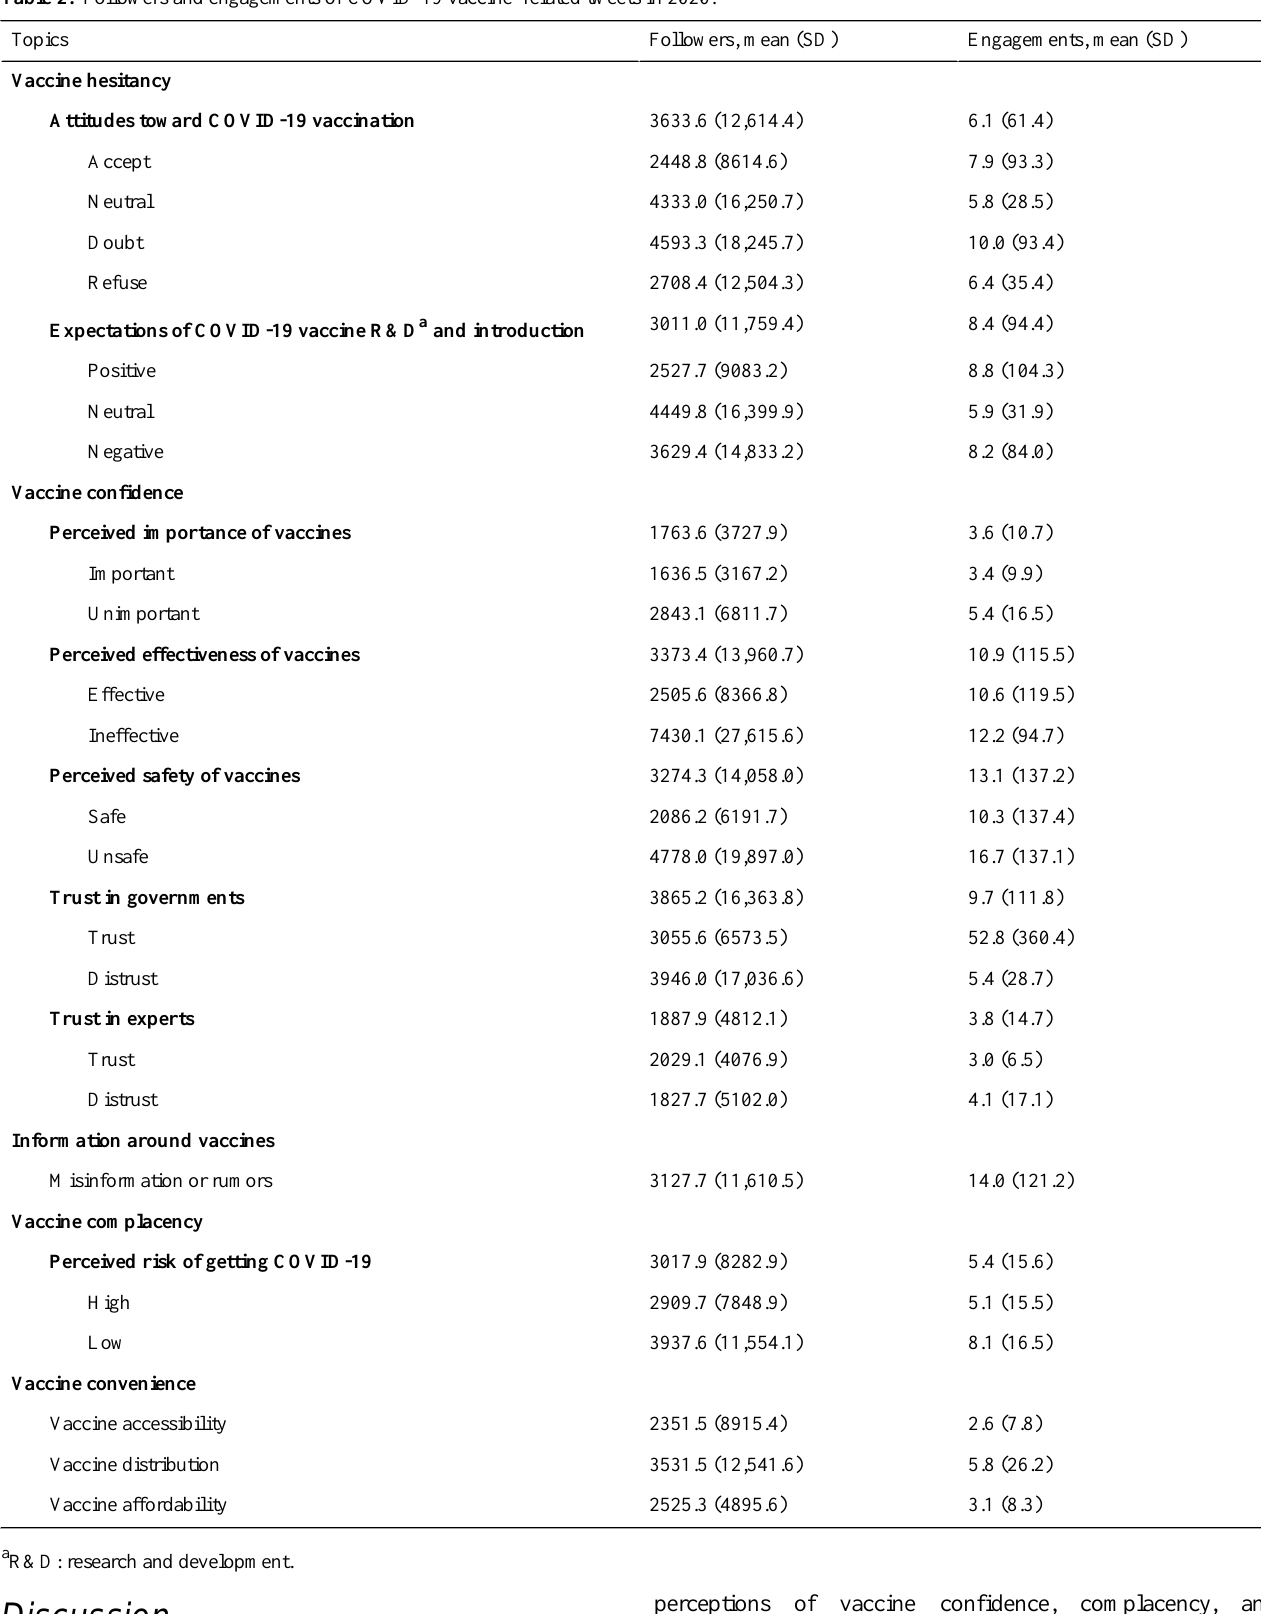
Engagements, mean (SD)Followers, mean (SD)Topics